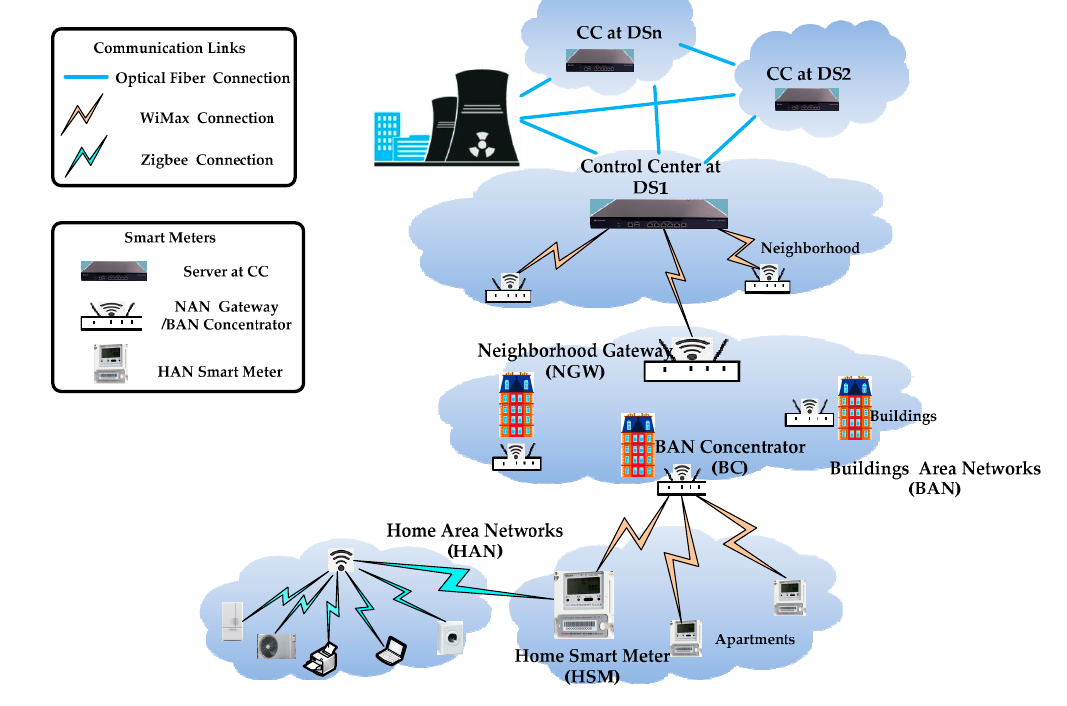
Figure 1. Hierarchical communication system model of smart grid.